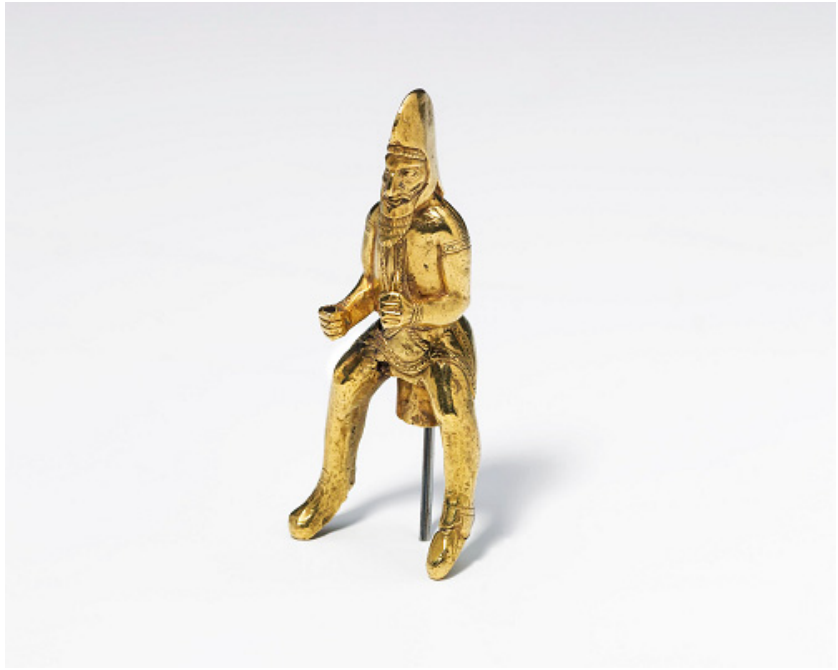
Figure 10. Rider wearing pointed cap (BM inv. no. 124098; reg. no. 1931,0408.1); figure, gold; found at Takht-i Kuwad (?) (Oxus Treasure), Tajikistan; Achaemenid, ca. 6th–4th cent. BCE [image courtesy of the Trustees of the British Museum, London].